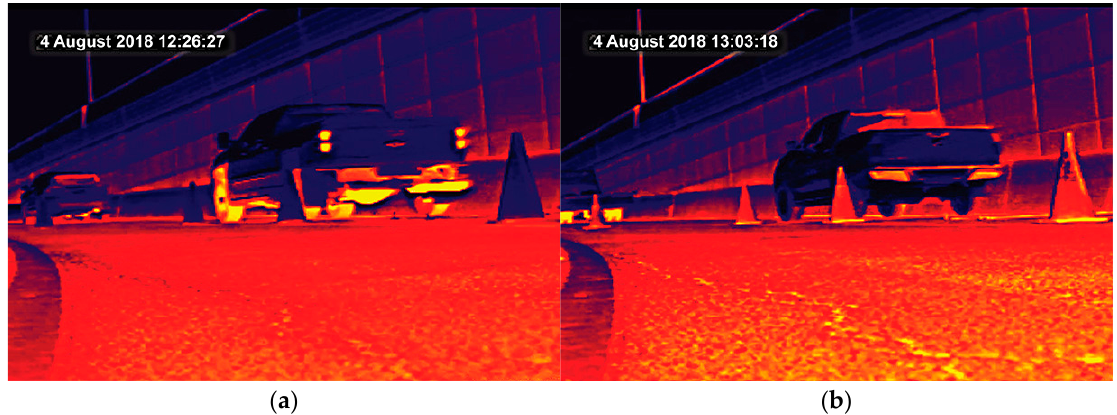
Figure 5. Examples of heat signature images of two vehicles, one assessed as being a ‘hot high emitter’ ( a ) and one as a ‘cold start high emitter’ ( b ).